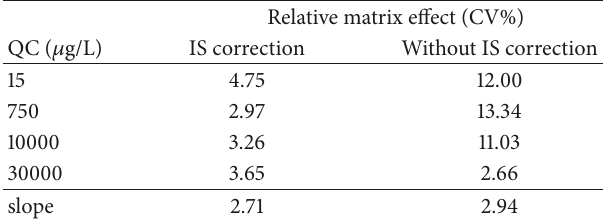
Table 2: Relative matrix effect data for RIF.